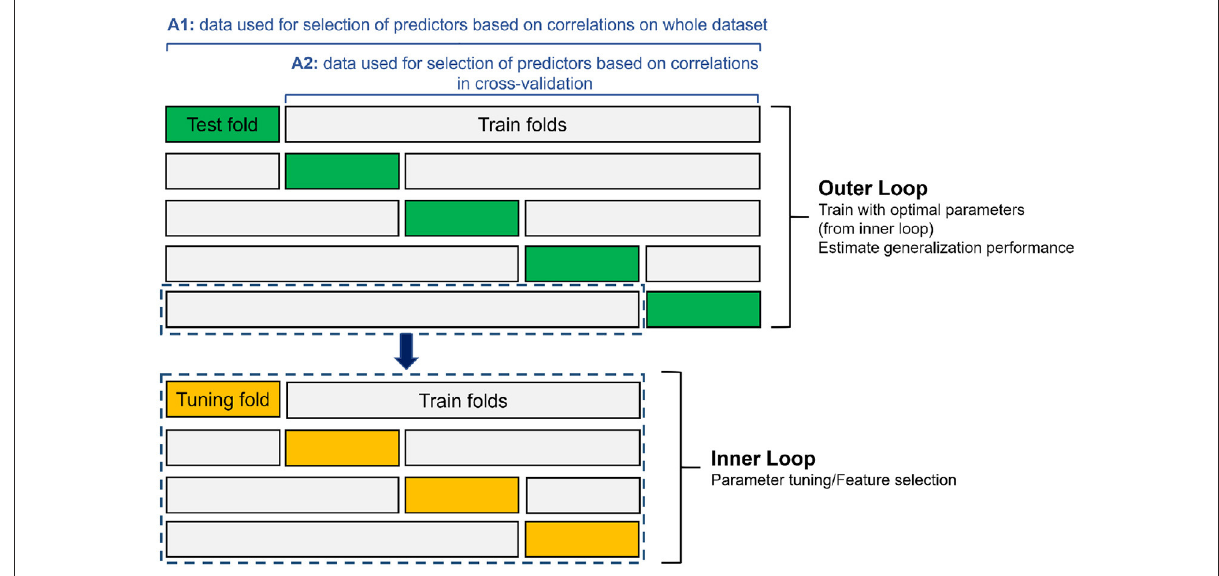
FIGURE2 Schematic overview of nested k-fold cross-validation procedure with 5 outer folds and 4 inner folds. A1 refers to the general approach with selecting predictors based on correlations on the whole dataset (1981–2014), while A2 refers to the approach where selection of predictors based on correlations is done only on the training data in the cross-validation procedure (see Section